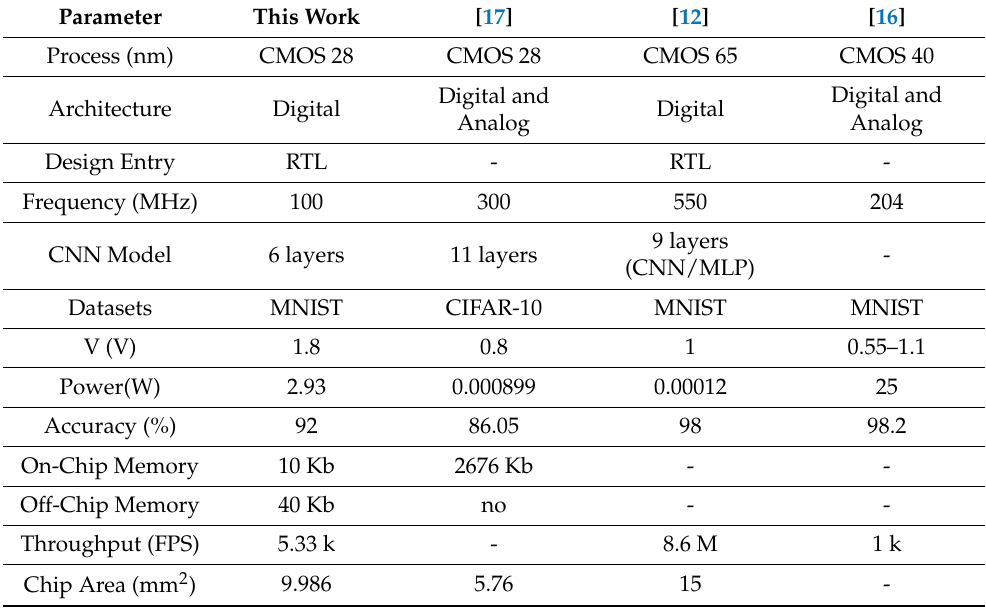
Table 1. Performance